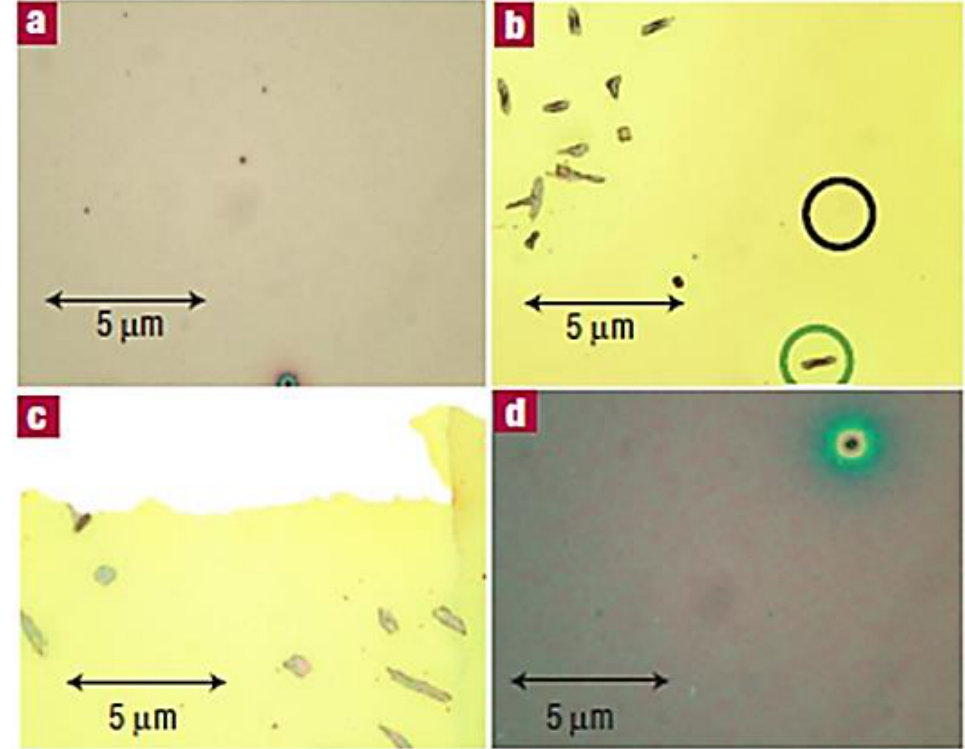
Figure 5. Optical microscope images for P3HT:PCBM film: ( a ) untreated (i.e., fast spin coated), ( b ) thermally annealed, ( c ) vapor annealed, and ( d ) slow dried. Inhomogeneities produced by impurities in ( d ) (upper-right corner of image) can often be seen in spin-coated P3HT:PCBM films [77]. P3HT:PCBM = poly(3-hexylthiophene):[6,6]-phenyl C 61 -butyric acid methyl ester. Reproduced with permission from Nature.